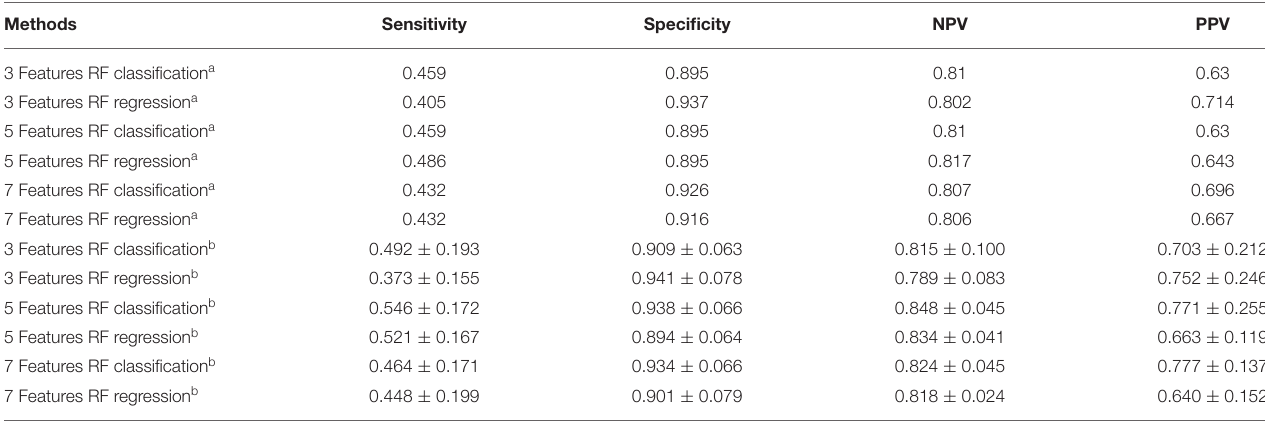
TABLE 3 | Performance of